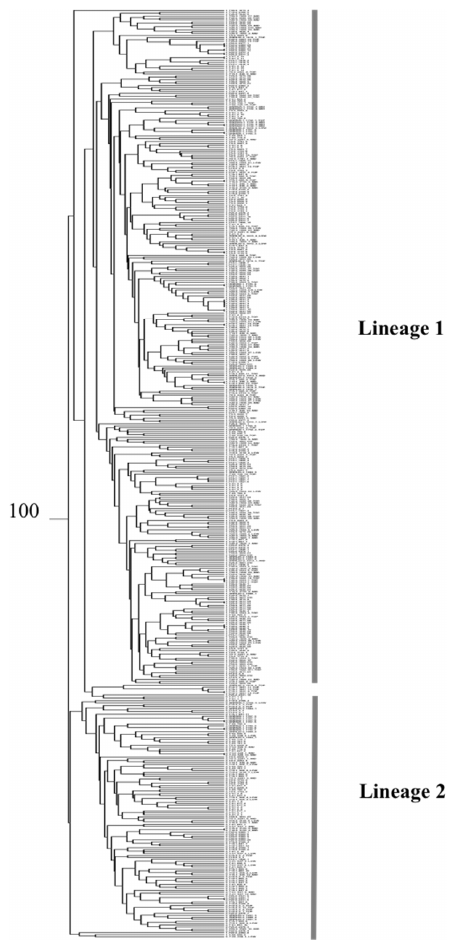
Figure 4. Unweighted pair ‐ group method using arithmetic means (UPGMA) dendrogram showing clustering among the 482 P. gaeumannii isolates due to genotypic similarity. The basal node label represents the bootstrap statistic from 1000 replicate trees. Genetic distance was calculated according to Rogers (1972).